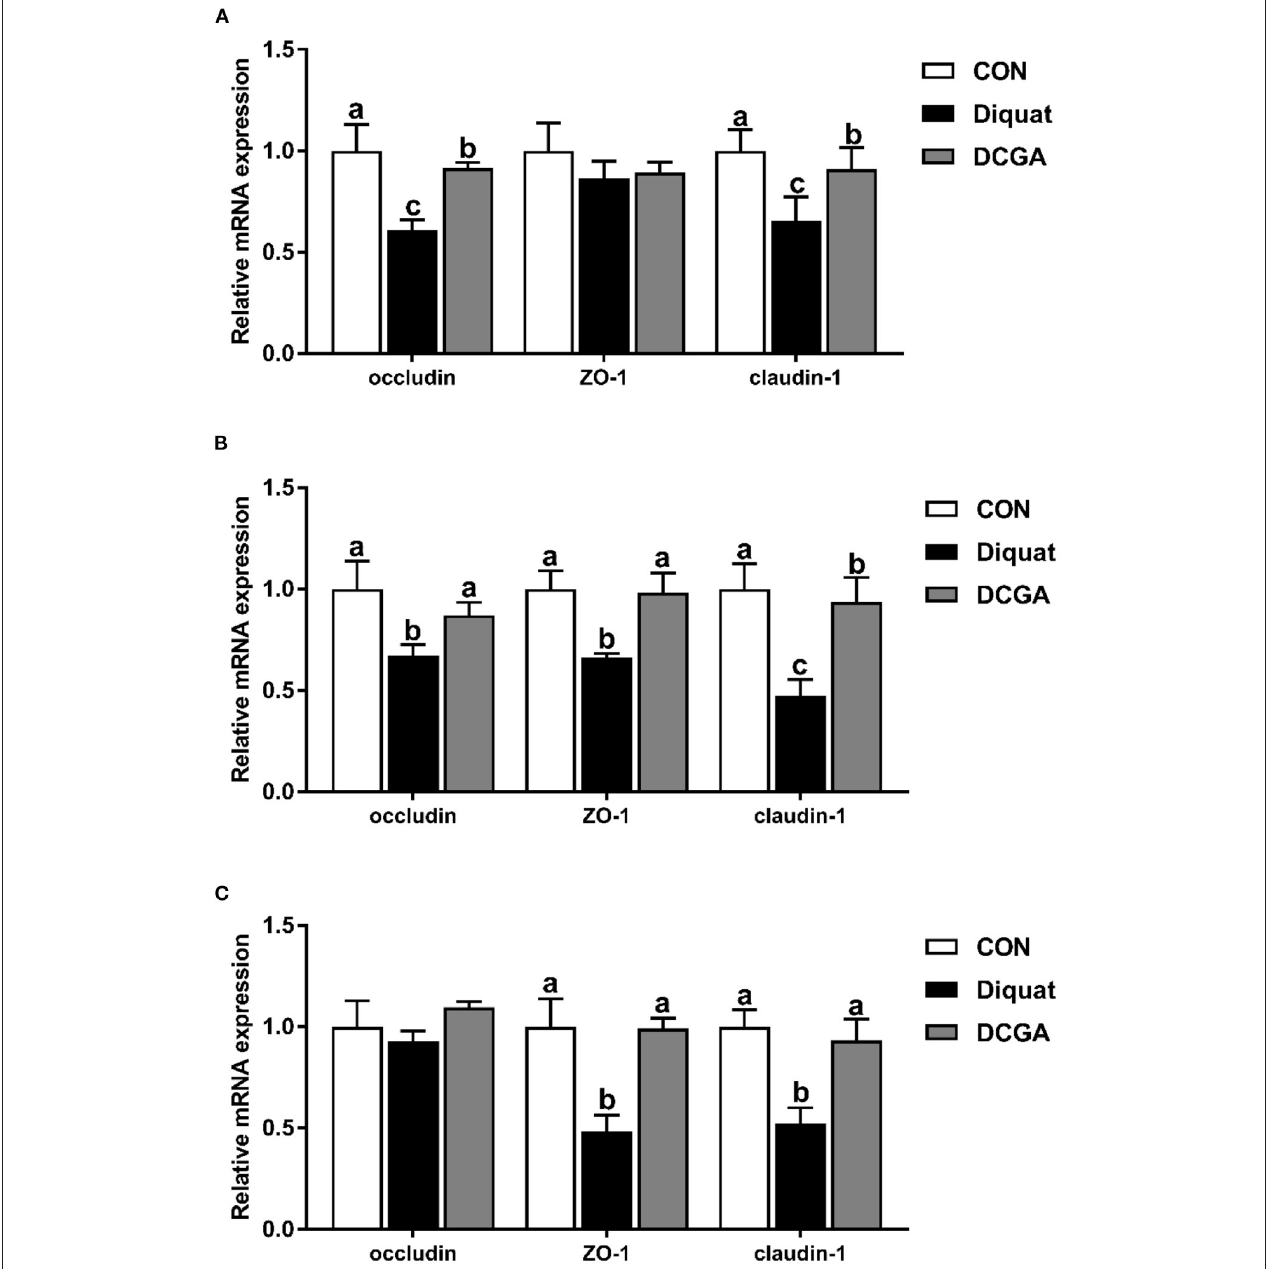
FIGURE 5 | Effects of CGA on expression levels of apoptosis-related genes in the Duodenum (A) , Jejunum (B) , and ileum (C) . Bcl2, B-cell lymphoma-2; Bax, B-cell lymphoma-2–associated X protein; CON, piglets fed a basal diet; Diquat, piglets fed the basal diet and challenged by diquat; DCGA, piglets fed the basal diet containing CGA (1,000 mg/kg) and challenged by diquat. a,b Bars with different letters between treatment groups indicate significant differences ( P <